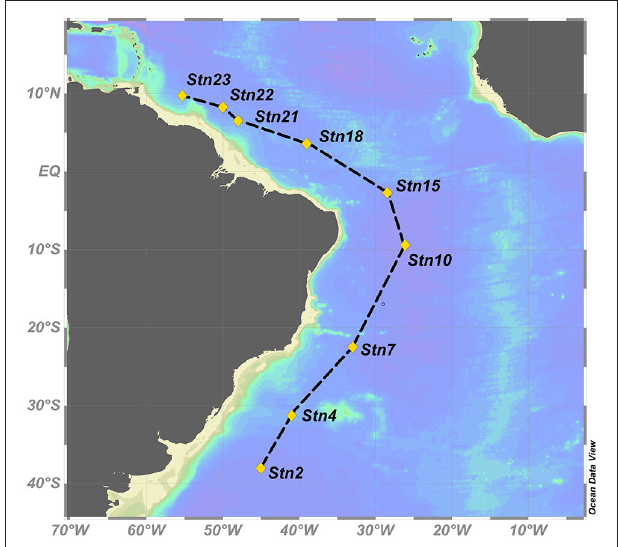
FIGURE 1 | Map of DeepDOM cruise track from 38S to 9N in the South Atlantic. Figure made in Ocean Data View Schlitzer, 2015.